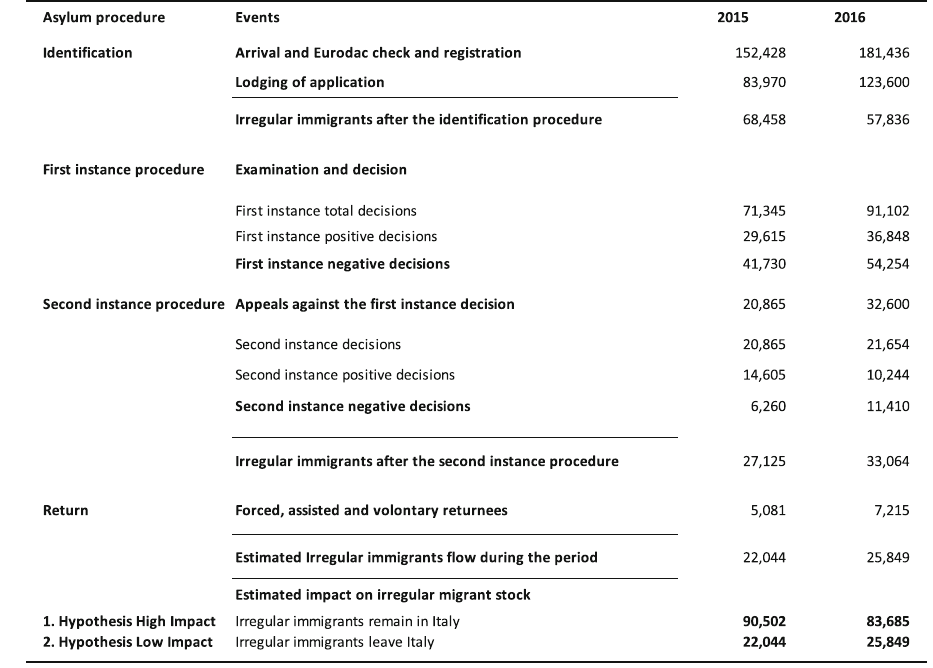
Table 2 Summary of migration events occurred in Italy, 2015 – 2016 (data sources: Ministry of Interior) and estimated increase of irregular migrant stock due to new sea arrivals at the end of